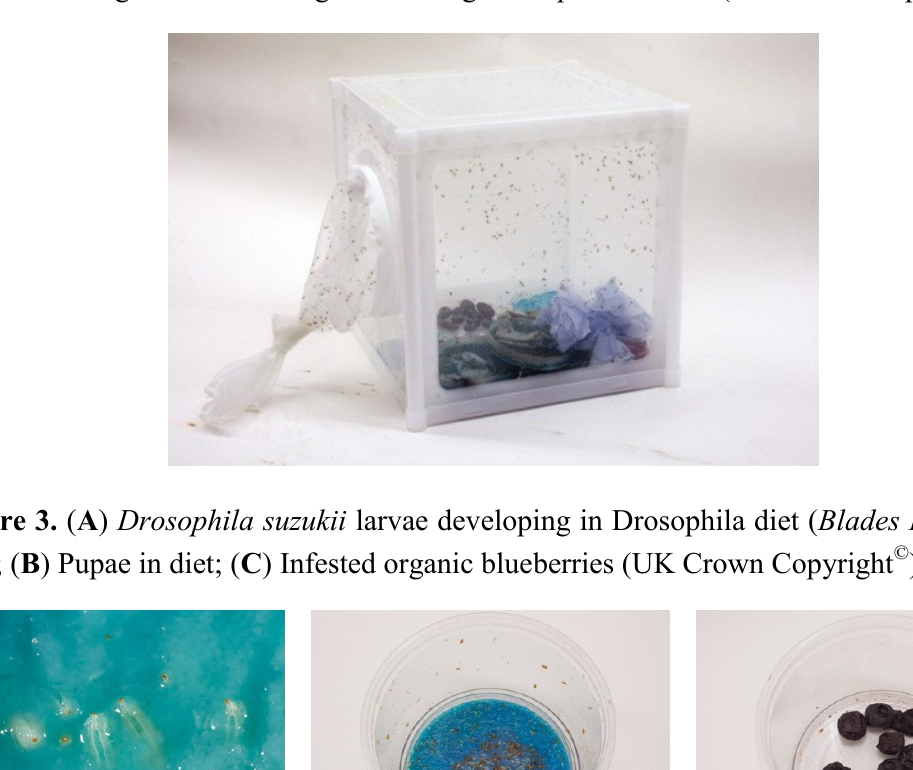
Figure 2. Bug-dorm insect cage containing Drosophila suzukii (UK Crown Copyright © ).